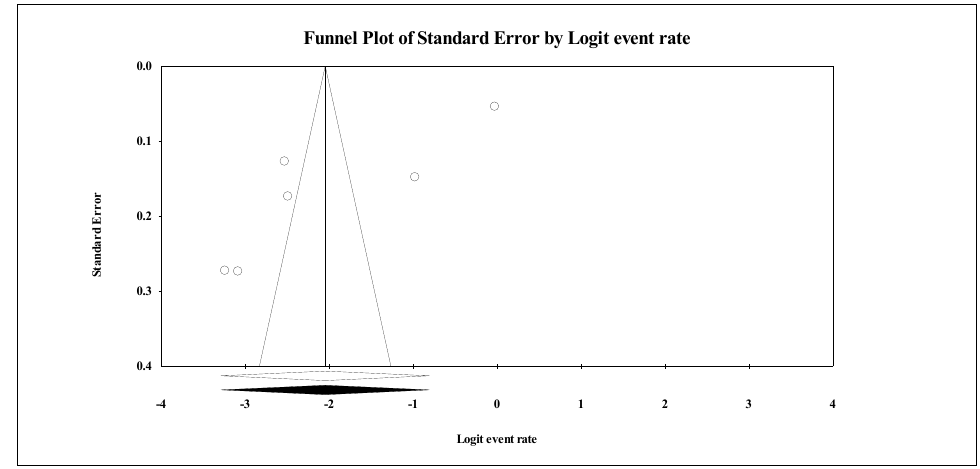
Figure A11. Funnel plot for studies on the prevalence of PTSD (Egger test: P = 0.22; Begg test: P = 0.90). The vertical solid line represents the summary effect estimates.